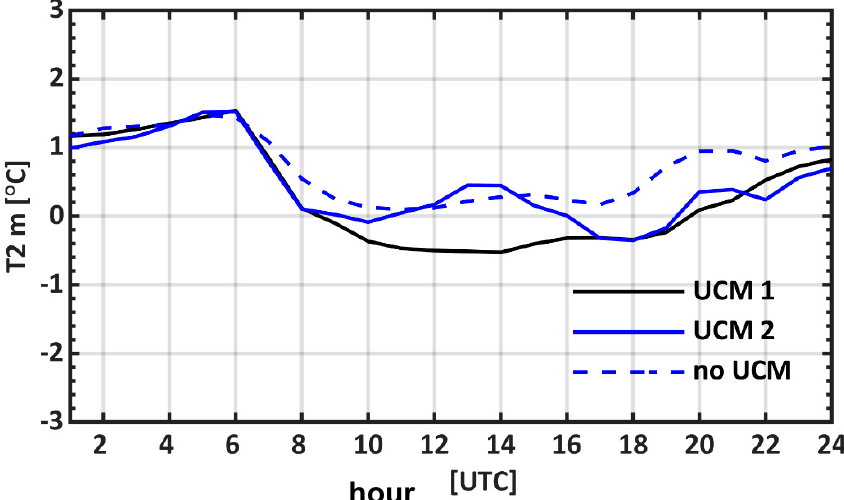
Figure 2. The average Urban Heat Island (UHI) intensity for Lisbon during the 2003 heat wave (from 29 July to 2 August 2003) for no_UCM, UCM1, and UCM2 (see text). Heat wave intensity is calculated as the difference between the urban minus rural average Tmax.